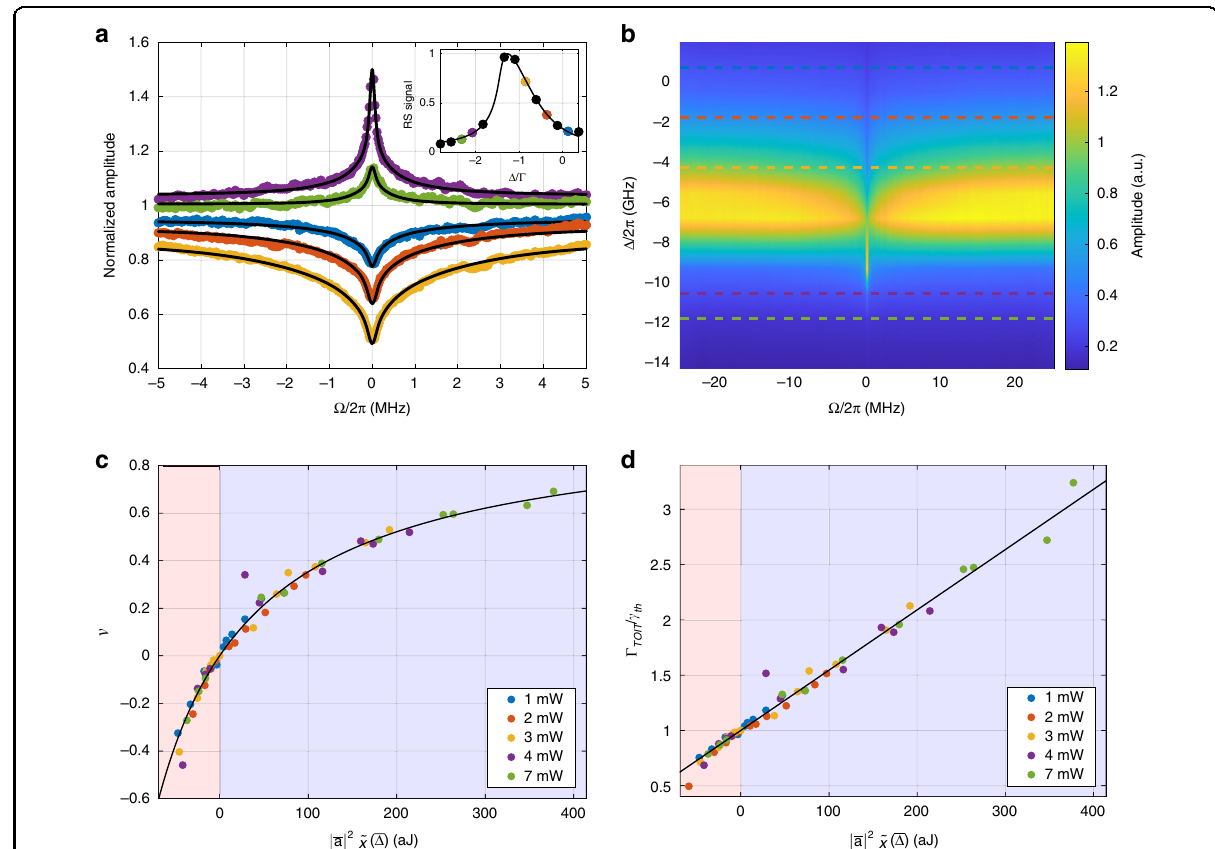
Fig. 2 Highly resolved amplitude response. a Normalized experimental spectra (dots) and model fi t (black curve) for the output power oscillation amplitude as a function of the control-probe detuning frequency Ω for a nominal control power P = 4 mW. The traces are normalized on the average value measured at Ω /2 π = ±25 MHz. (inset) Time-averaged RS power collected during each scan (dots) and best fi t with a bistable nonlinear model (black curve) as a function of the detuning Δ = ω c − ω 0 between the control frequency and “ cold ” cavity resonance frequency. Colored points correspond to measured spectral traces and provide control- “ hot ” cavity detuning conditions, Δ , and coupled power, a j j 2 . b Color map of the output (cid:1) (cid:1) (cid:1) (cid:1) as a function of the control-probe detuning frequency and control-cavity detuning. Horizontal slices correspond to power oscillation amplitude ~ I (cid:6) (cid:7) experimental traces in a . c Dip (blue region, positive values) and peak (red region, negative values) visibility as a function of the product a j j 2 ~ χ Δ . The visibility is calculated from a best fi t of the experimental spectra for the whole experimental dataset. The legend reports the nominal laser power for (cid:6) (cid:7) each measurement. d Linewidth broadening (narrowing) as a function of a j j 2 ~ χ Δ . The values on the vertical axis are calculated upon the data in c as ¼ 1 = 1 (cid:2) Vð Γ TOIT = γ th